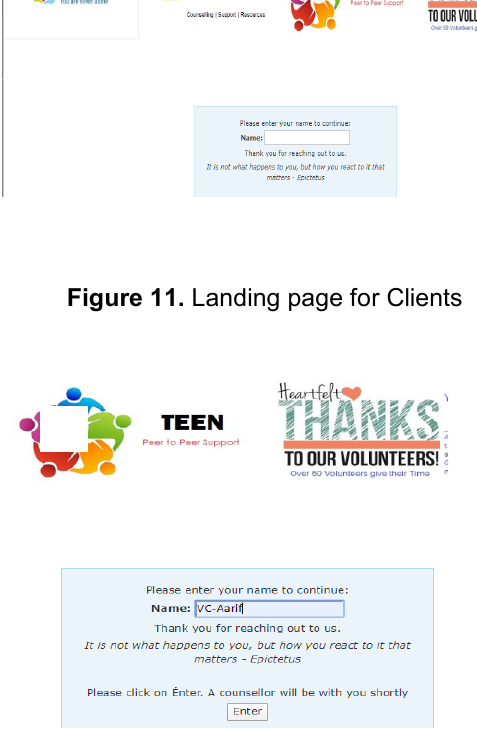
Figure 12. Landing page for